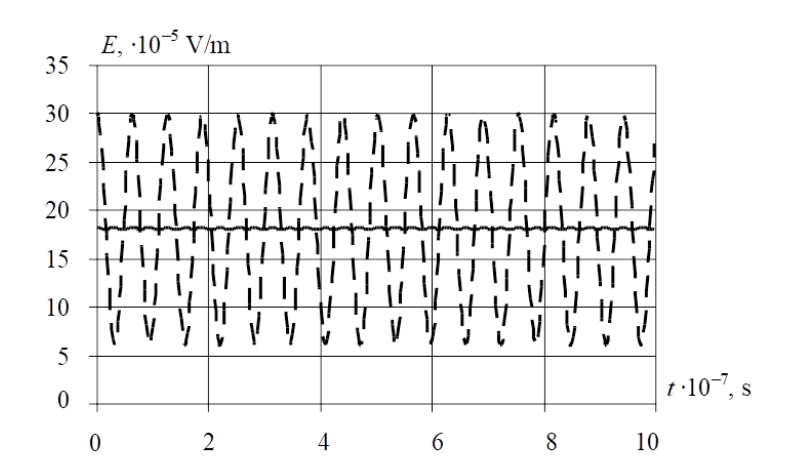
Fig. 3. Dependence of the electrical field intensity of the film on time 2/  rad, 0,1  mn (solid line – 2/  rad, dotted line – 0  rad).